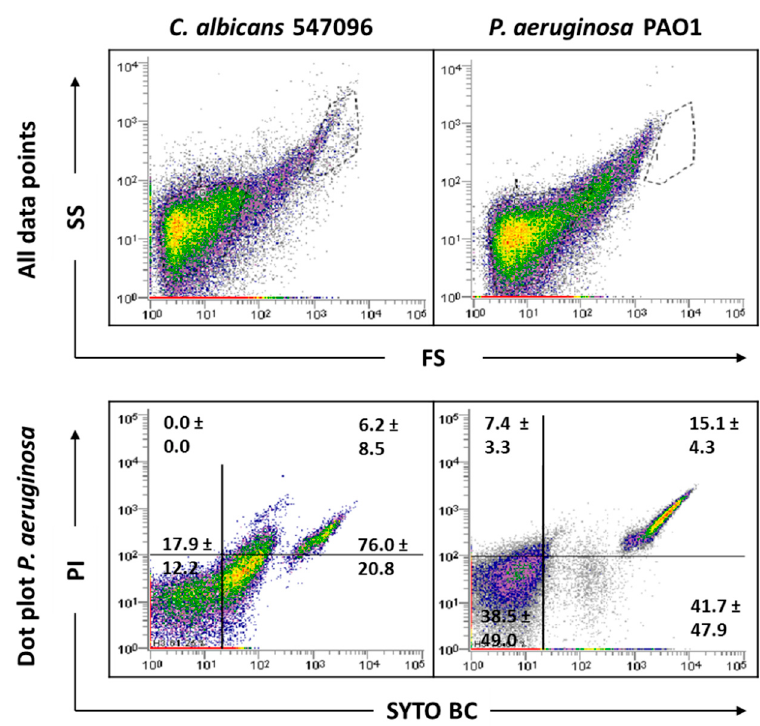
Figure 3. Representative dot plots obtained for biofilm matrix of C. albicans 547096 and P. aeruginosa PAO1 by FCM. In ‘all data points’, the dot plots SS (Side Scatter) × FS (Forward Scatter) are represented, as acquired in the logarithm. The dot plot of P. aeruginosa represents the areas delineated to represent bacteria.